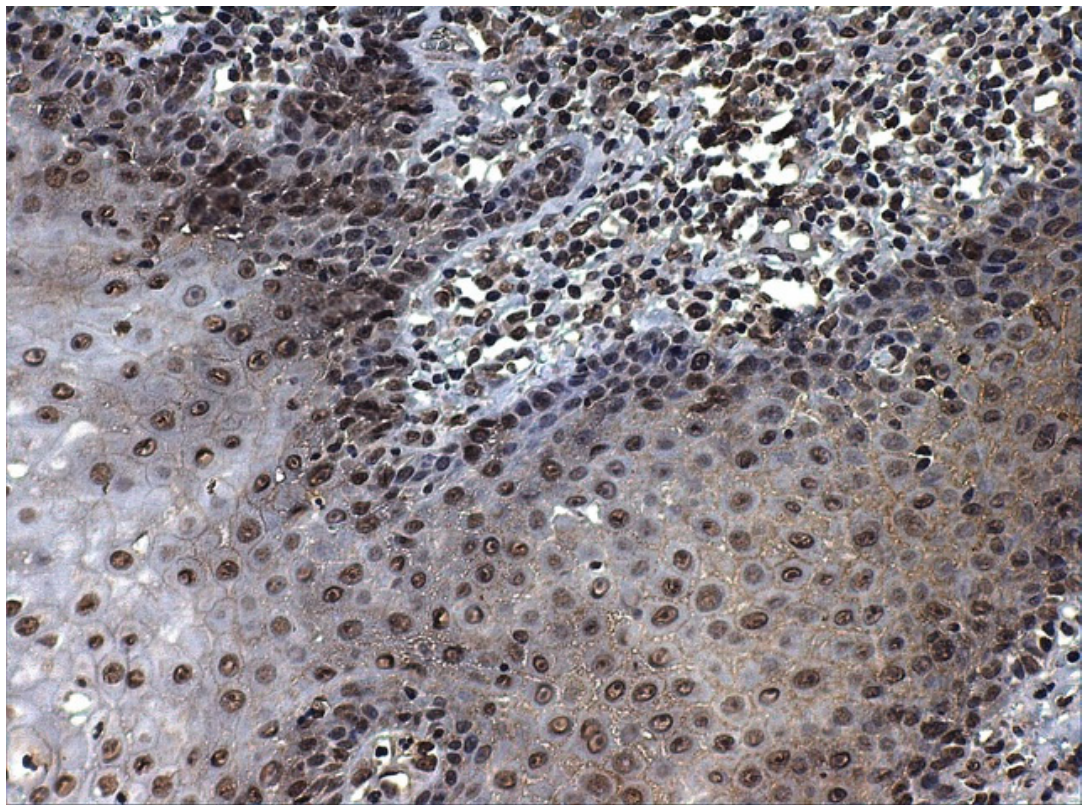
Figure 3. SP immunostaining of nuclei of epithelial cells in non-neoplastic epithelium. SP can be detected, in this case, both in keratinocytes and also in the nuclei of subepithelial lymphocytes.